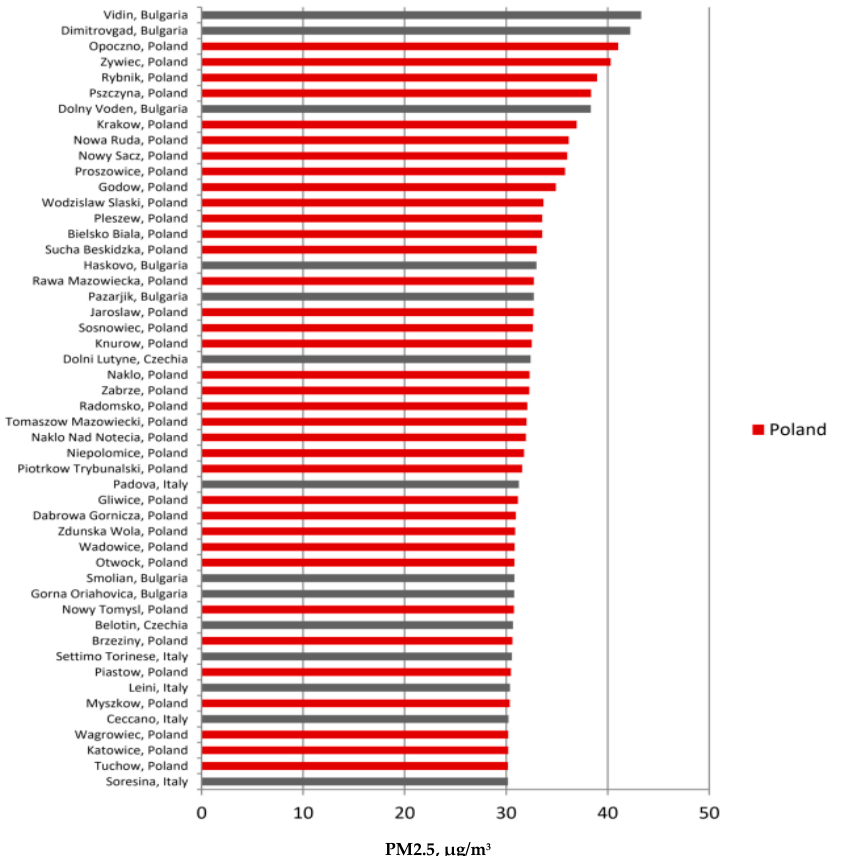
Figure 2. 50 most polluted cities in the European Union in 2019.